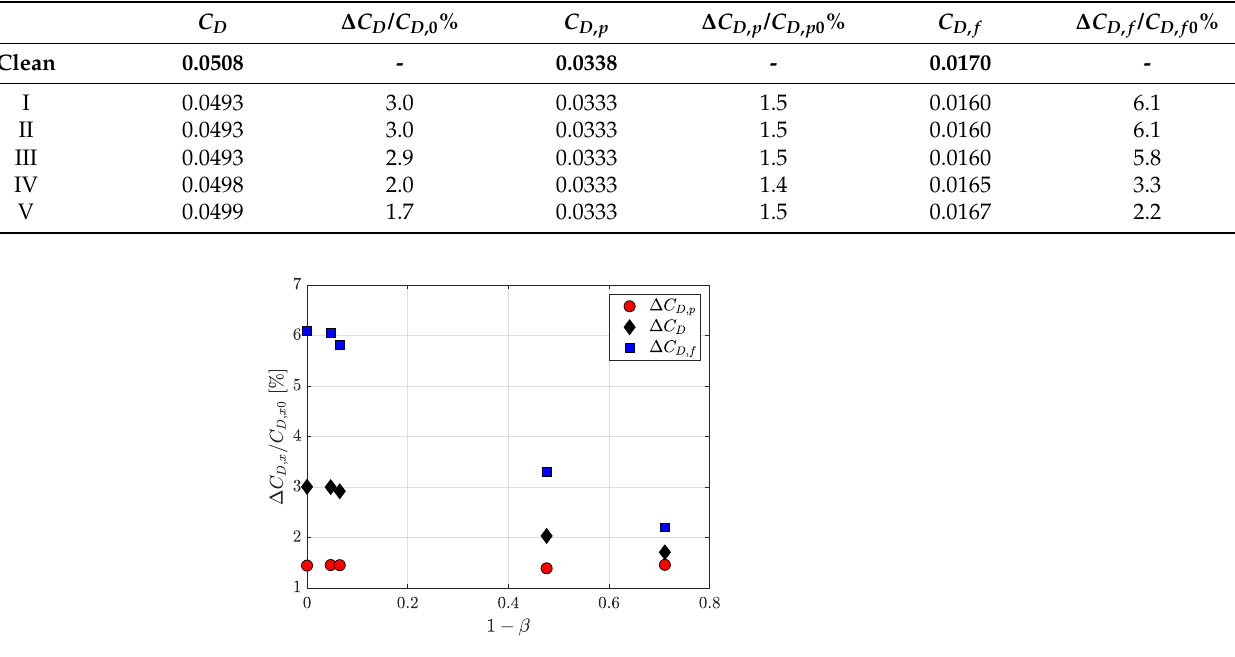
Figure 15. Drag reduction contributions for different configurations of riblets coverage from highest (I-full coverage) to lowest (V-wing only, suction side) coverage.